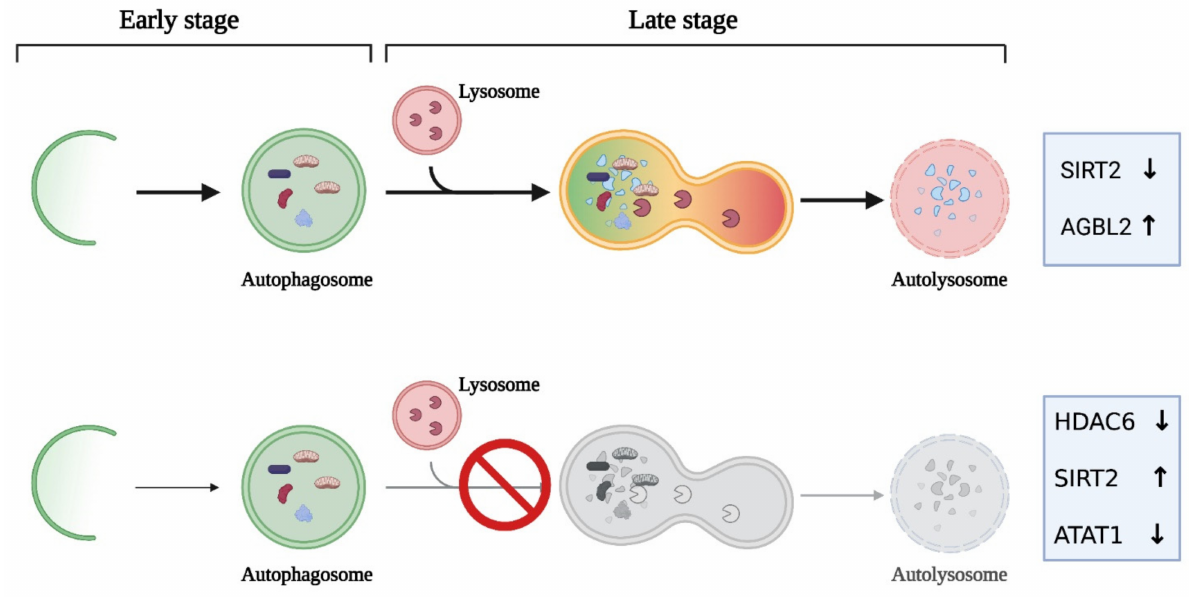
Figure 4. Modulation of tubulin-modifying enzymes impacts differently on autophagic flux. Down- regulation of SIRT2 or AGBL2 upregulation promotes functional autophagy. On the contrary, dif- ferential expression of the tubulin acetylase ATAT1 or of HDAC6 and SIRT2 deacetylases induces autophagosome accumulation by blocking late autophagic stages. Image created with